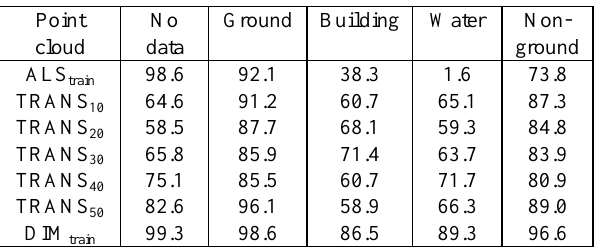
Table 2. Class-dependent F1- Score for DIM test [%]